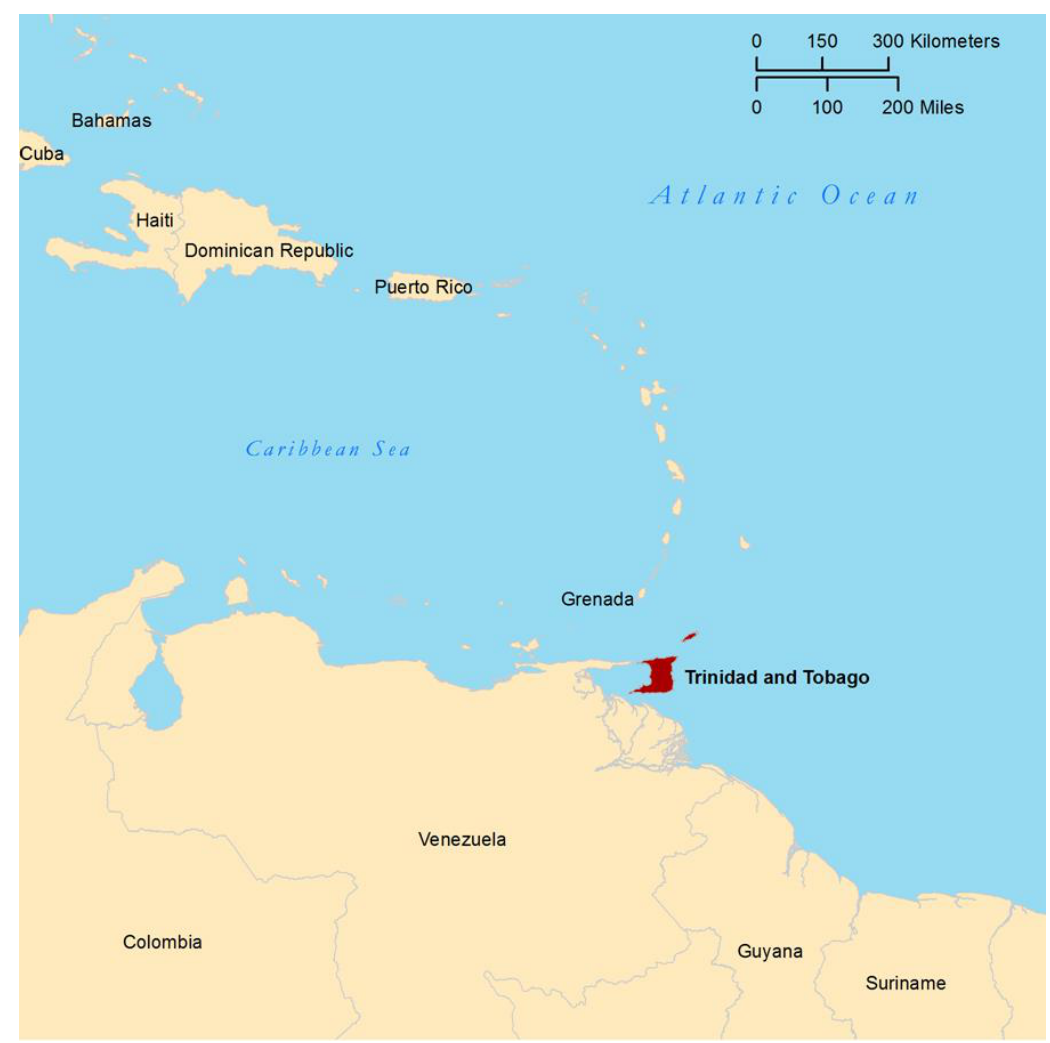
Figure 1. Location of Trinidad and Tobago relative to South America, Venezuela, and other Caribbean islands. Map created with the assistance of T. W. Shawa, Princeton Geographic Information Systems Librarian.